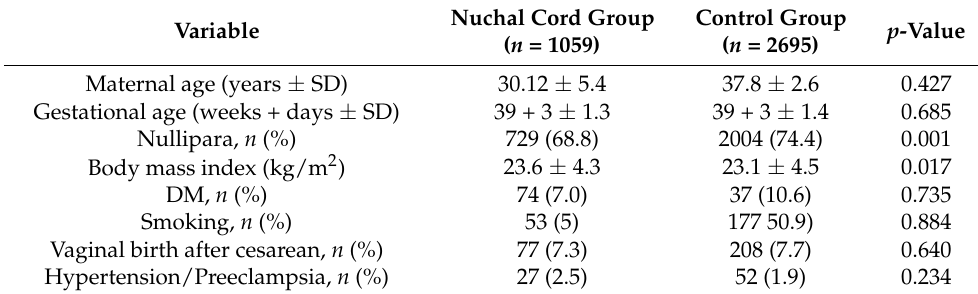
Table 1. Baseline characteristics of the study